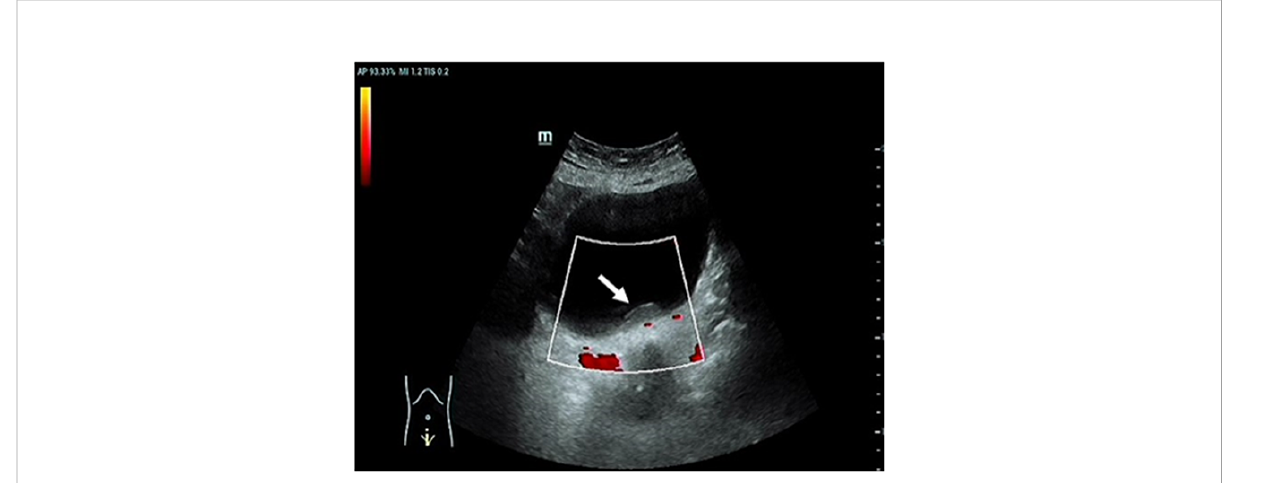
FIGURE 1 Color ultrasound. This image showed a hypoechoic mass in the posterior wall of the bladder. CDFI: no blood fl ow signal in the mass